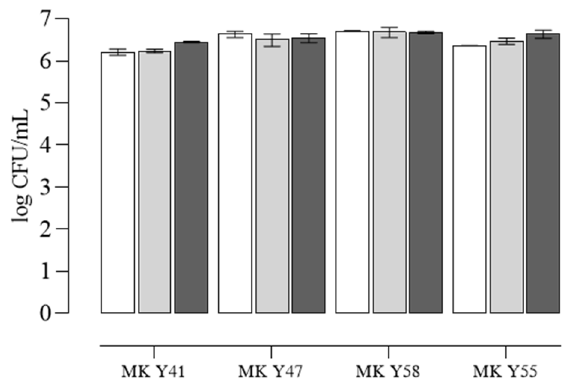
Figure 3. Survival (mean ± standard deviation, n = 3) of K. marxianus strains during exposition to simulated gastrointestinal conditions. White bars: initial concentration; light grey bars: yeast concentration after 3 h (gastric phase); and dark grey bars: yeast concentration after 4 h (enteric phase).